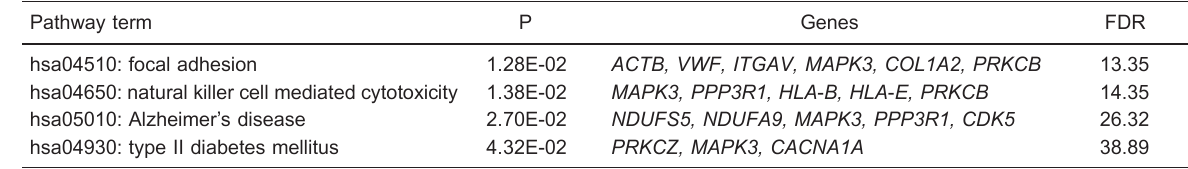
Table 3. KEGG pathway annotation of 73 differentially expressed